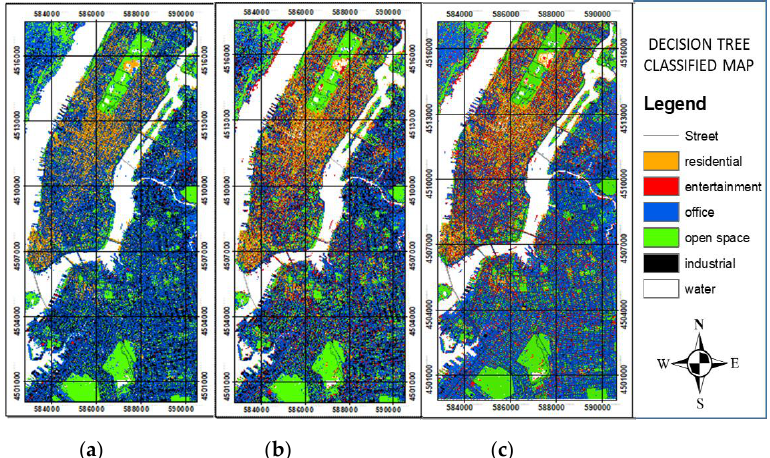
Figure 15. Six-class decision tree classified map using ( a ) remote sensing only; ( b ) integration of remote and social sensing (without data cleaning); ( c ) integration of remote and social sensing (with data